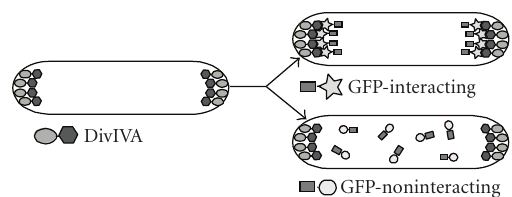
Figure 1: Cartoon of the assay under study; DivIVA directs local- ization of protein of interest 1 (POI1) to the poles. GFP-POI2 relo- cates to the cell poles if POI1 and POI2 directly interact. GFP-POI2 remains di ff usely localized if no interaction